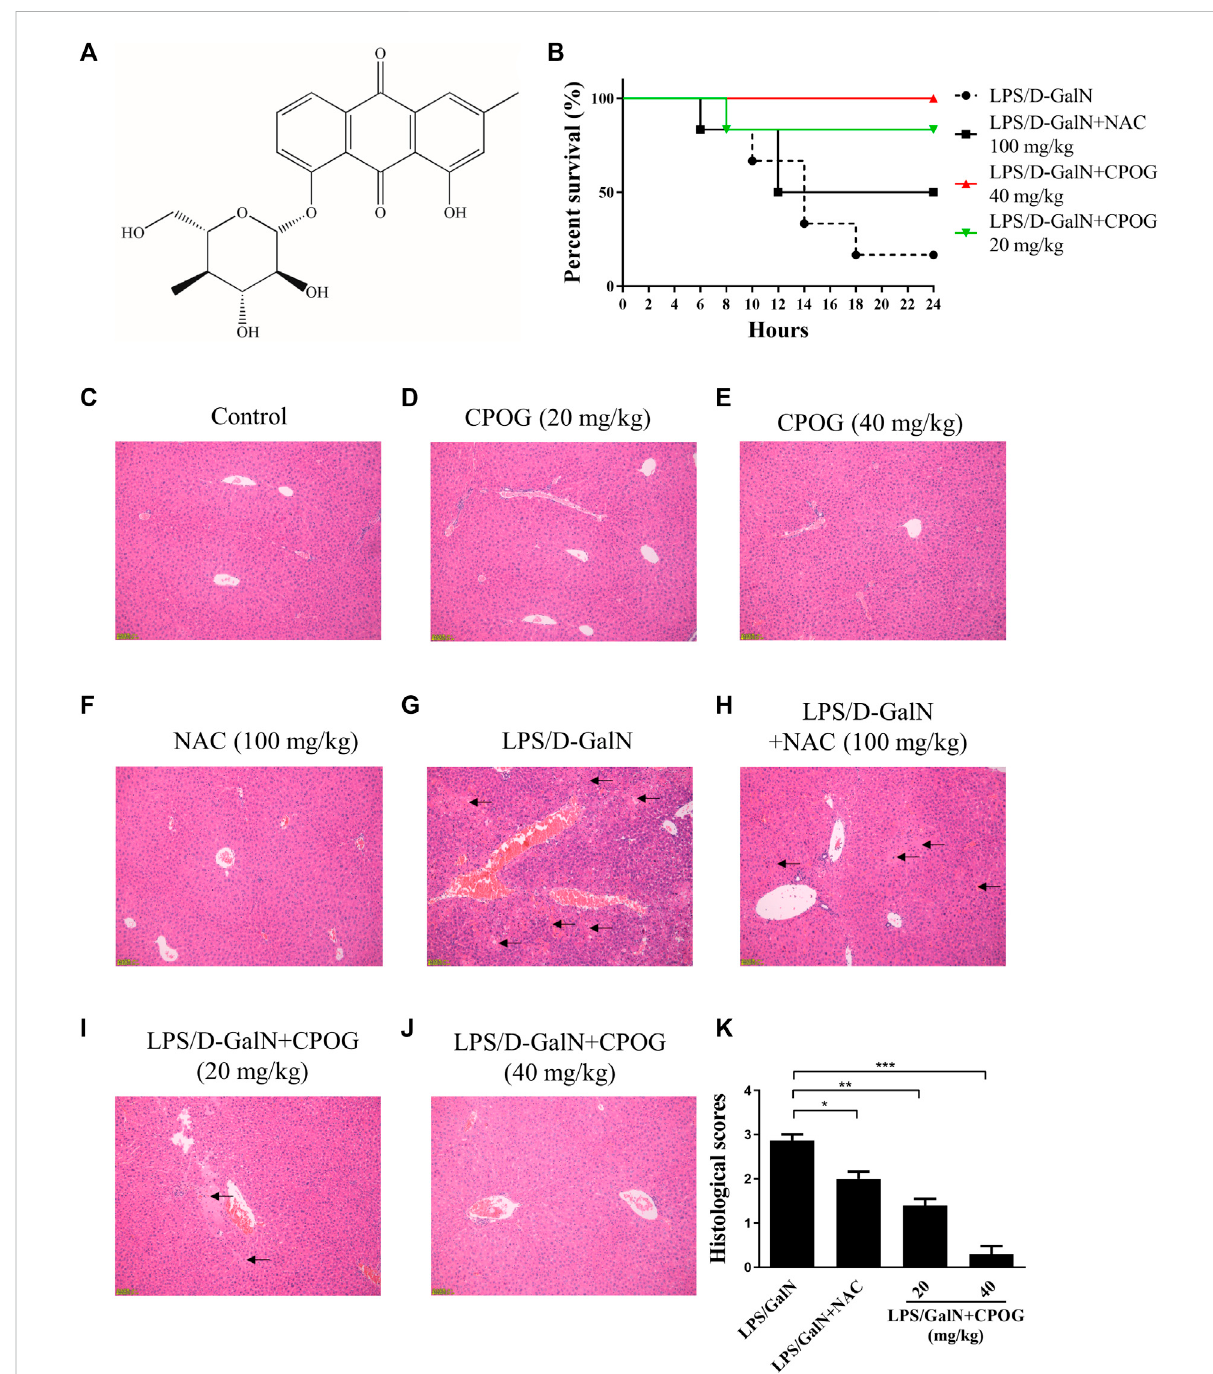
FIGURE 1 CPOGameliorates LPS/D-GalN-induced ALF. (A) ChemicalstructureofCPOG. (B) Kaplan-Meiermethod wasusedtocreatethesurvivalcurves after LPS/D-GalN injection. (C – G) Liver sections were subjected to H&E staining. Representative photographs were shown from vehicle mice (C) , micetreatedwithCPOG(20 mg/kg) (D) ,micetreatedwithCPOG(40 mg/kg) (E) ,micetreatedwithNAC (F) ,micetreatedwithLPS/D-GalN (G) ,mice treated with LPS/D-GalN and NAC (H) , mice treated with LPS/D-GalN and CPOG (20 mg/kg) (I) , mice treated with LPS/D-GalN and CPOG (40 mg/kg) (J) . Arrows represent pathological changes in liver tissue. (K) Histological scores of liver sections were determined. Values represent mean ± S.D. one-way ANOVA test was used to determine the signi fi cances. * p < 0.05, ** p < 0.01, *** p <